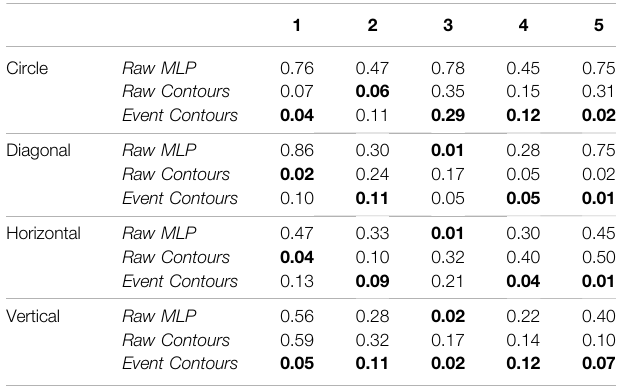
TABLE 1 | Mean errors in the ratio of computed contact location and BioTac SP width at each way-point over different trajectories. The values in bold refer to the best results for a given